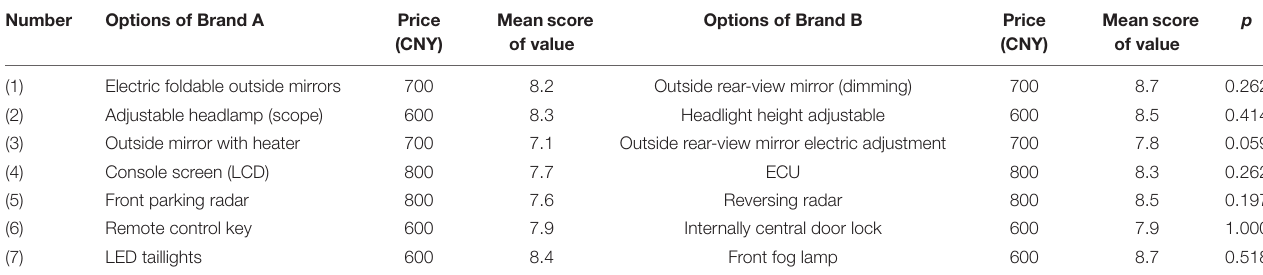
TABLE 3 | Prices and utility scores of the two models’ seven options.